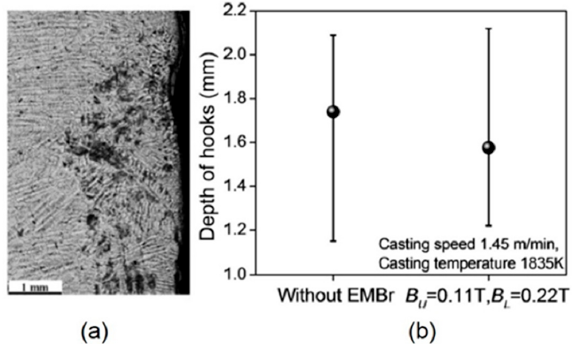
Figure 19. ( a ) Subsurface hooks and ( b ) the effect of double-ruler EMBr on hook depth in the steel slab [132].